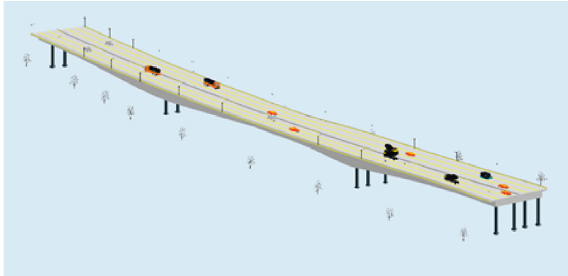
Figure 1: Steel box girder bridge.